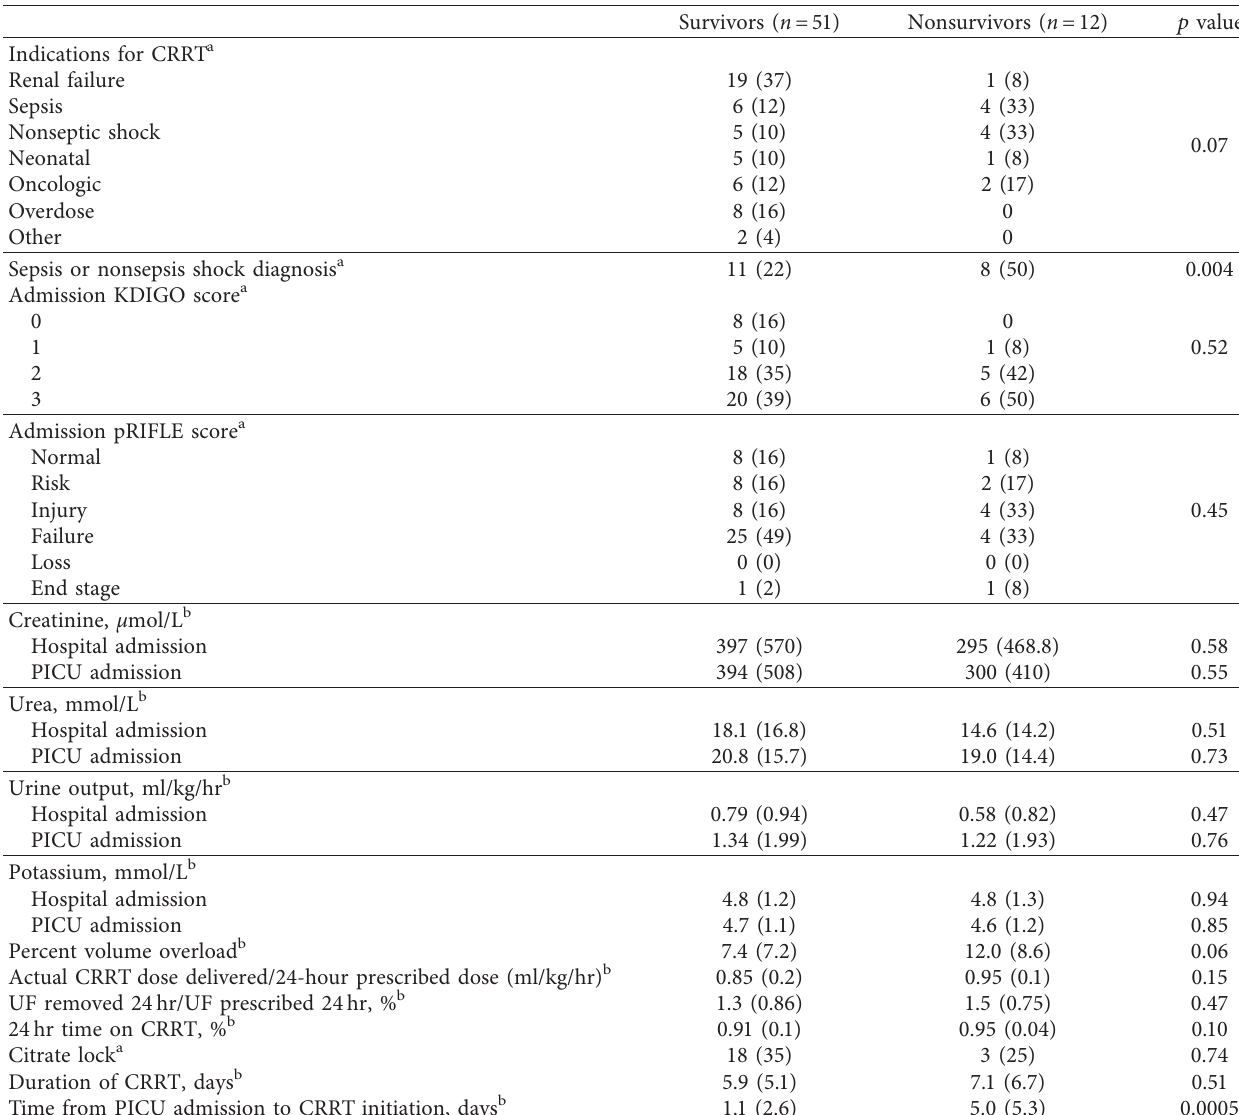
Table 2: Renal and continuous renal replacement metrics.